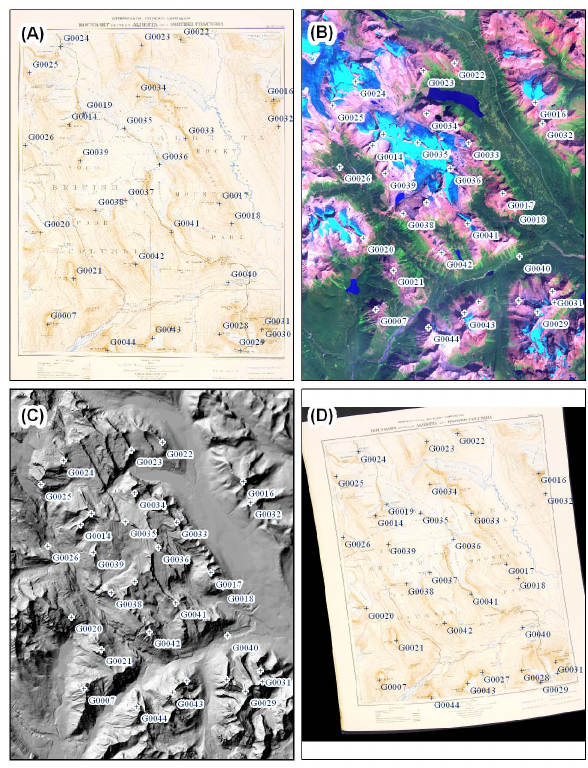
Fig. 2. (A) Example of a raw IBCS map that was rectified using 30 GCPs collected from (B) previously rectified Landsat imagery and (C) BC TRIM hillshading to produce (D) a rectified map from which glacier extents and contours were